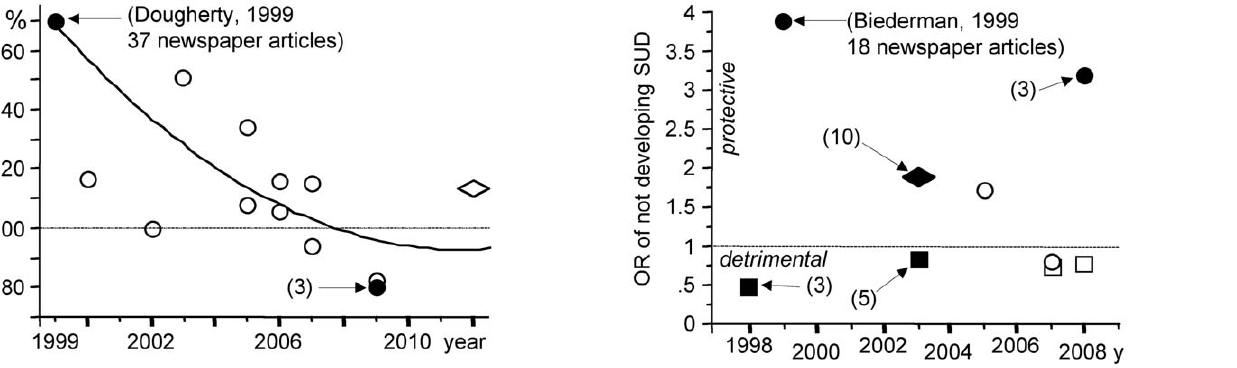
Figure 4. Impact of ADHD pharmacotherapy on later substance use disorder (SUD). According to the ‘‘top 10’’ study published by Biederman et al. in 1999, ADHD children treated with psychostimulants are at a 4-fold reduced risk of later SUD at adolescence. This study and two studies published in 1998 and 2003 were taken into account in a meta-analysis (corresponding OR indicated by a diamond). Circles indicate pharmacotherapy outcome for SUD at adolescence and squares at adulthood. Scientific studies echoed by newspapers are indicated by filled symbols (number of articles in parentheses). Empty symbols indicate that the corresponding scientific article has not been echoed by newspapers.